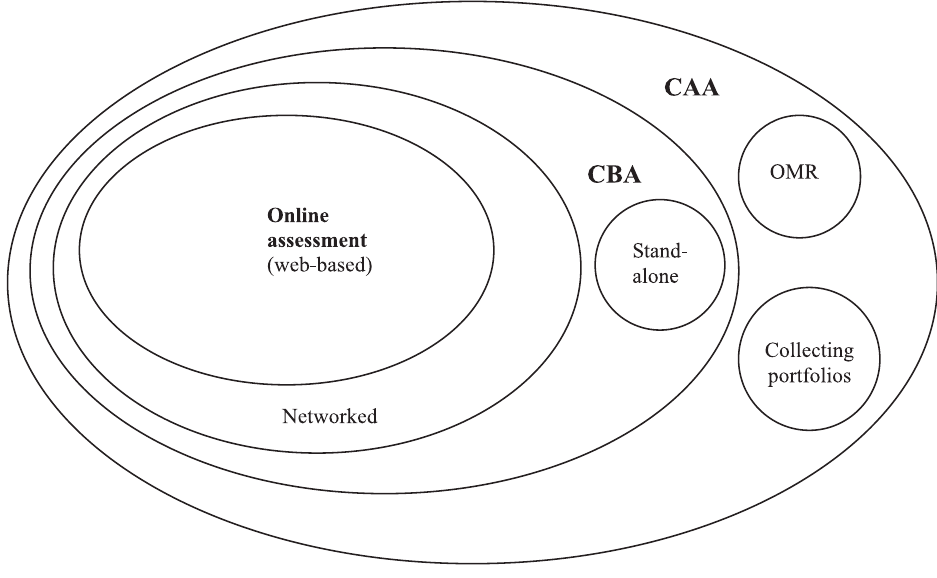
Figure 1. Different types of